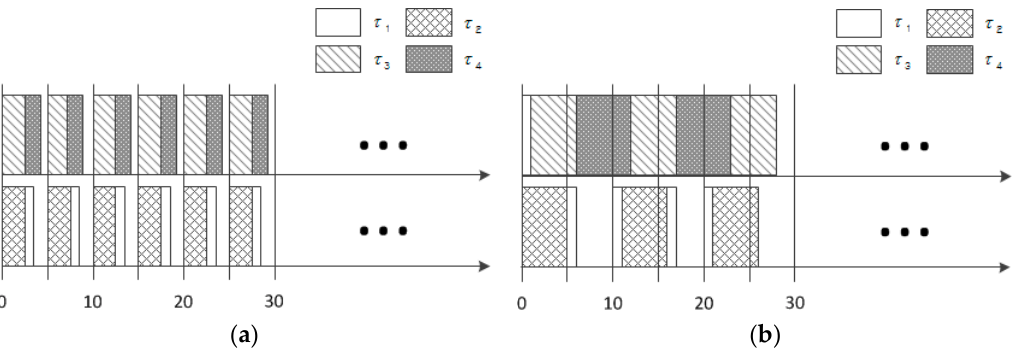
Figure 1. Example of idle time fragmentation: ( a ) LNREF schedule and ( b ) global-EDF schedule.